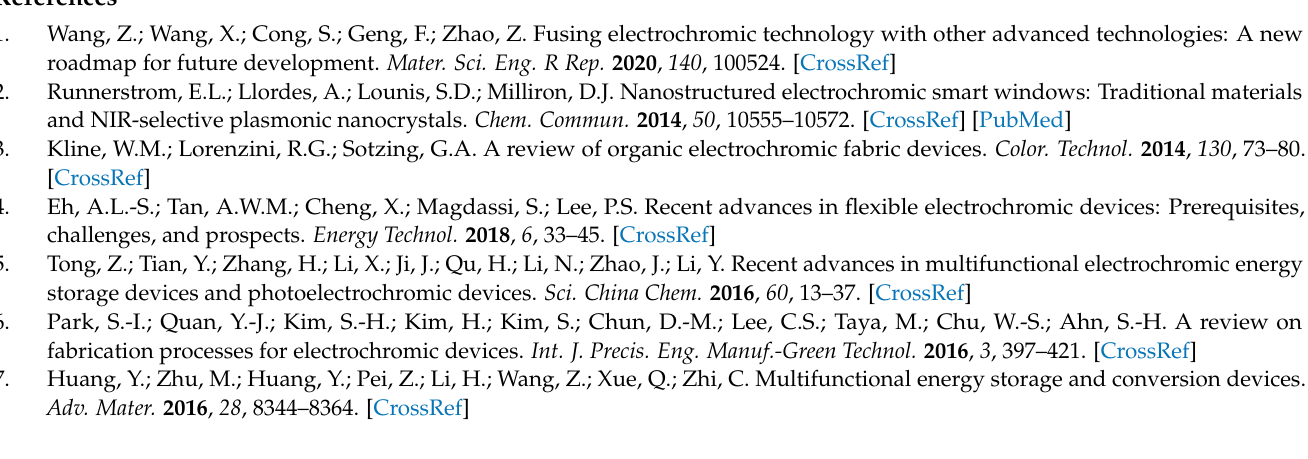
Table S3: Detailed electrochromic data of PBDT-IIDs under different process